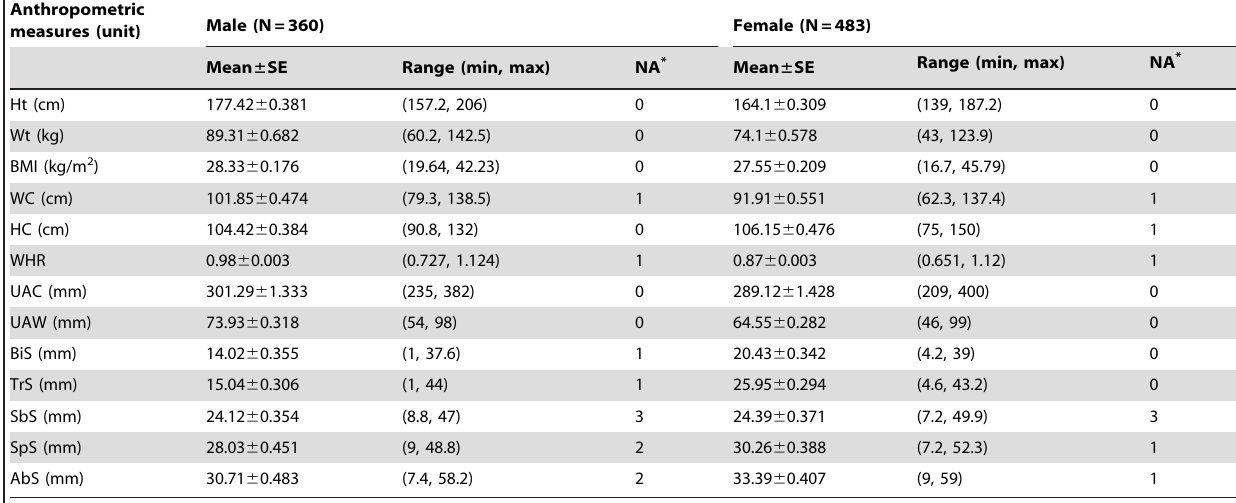
Anthropometric measures (unit)